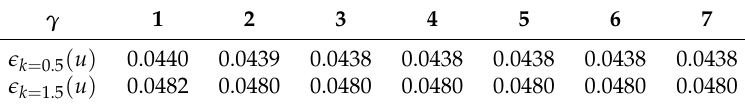
Table 2. k = 0.5,1.5, q = 5, ε = 0.01, the errors for different γ